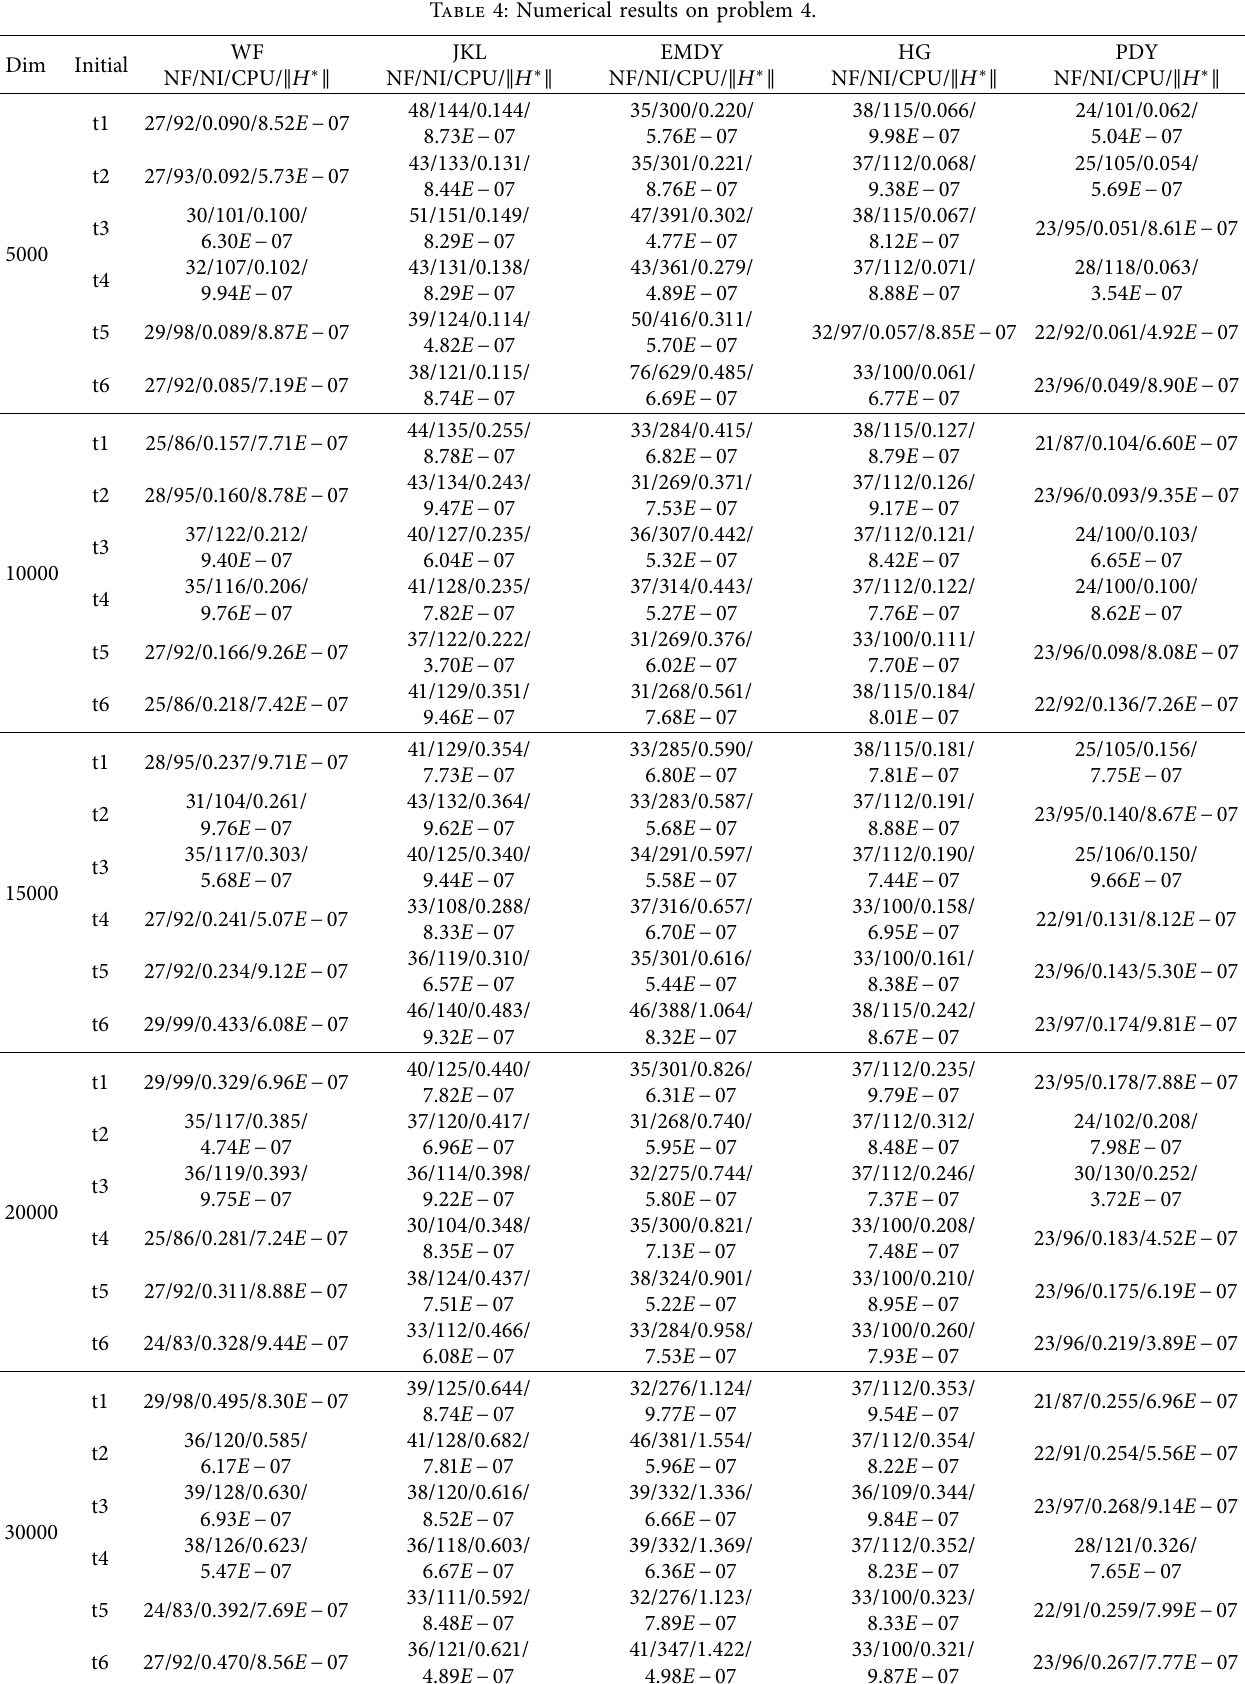
Table 4: Numerical results on problem